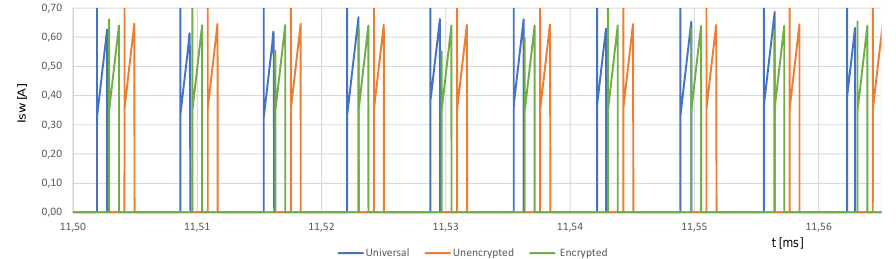
Figure 28. I sw LM2594 models time graph curves. The current through the coil I L time graph curves is shown in Figure 29. The curves are again almost identical. The figures show that the officials and universal model results are very close to each other.